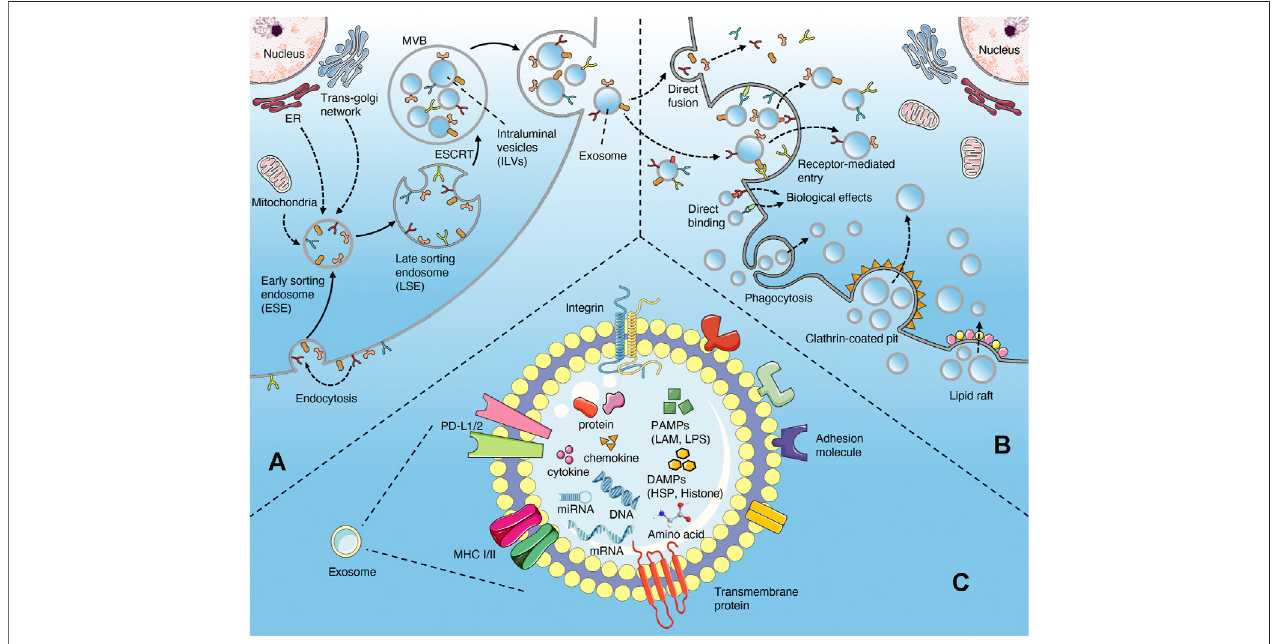
FIGURE1| Biogenesisanduptakeofexosomes (A) theexosomesoriginatefromtheinvaginationoftheplasmamembrane,followedbytheformationofESE,LSE, MVB (contain ILVs), and ultimately be released through the fusion of MVB with the plasma membrane (B) the uptake of exosomes may involve directly fusion, receptor- mediated endocytosis, phagocytosis, clathrin-coated pits and lipid raft. In addition, exosomes can interact with cells via directly binding way (C) the contents of exosomes in sepsis include proteins, nucleic acids, cytokines, chemokines, PAMPs, and DAMPs.